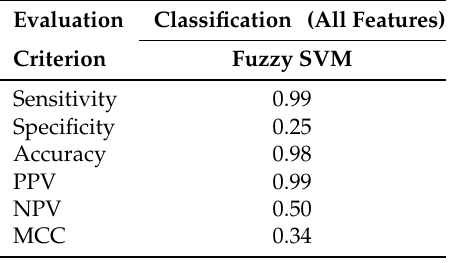
Table 8. Performances Assessment for intuitionistic possibilistic fuzzy c-mean (IPFCM).